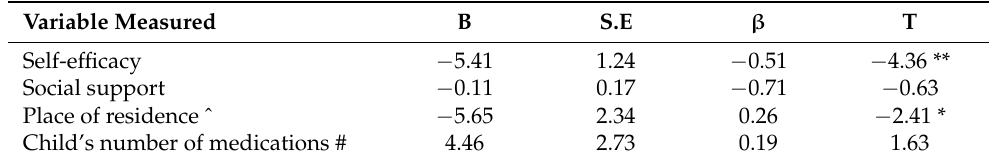
Table 2. Predictors of mothers’ caregiving burden: Results of multivariate linear regression analysis. Variable Measured B S.E β T Self-efficacy − 5.41 1.24 − 0.51 − 4.36 ** Social support − 0.11 0.17 − 0.71 − 0.63 Place of residence ˆ − 5.65 2.34 0.26 − 2.41 * 4.46